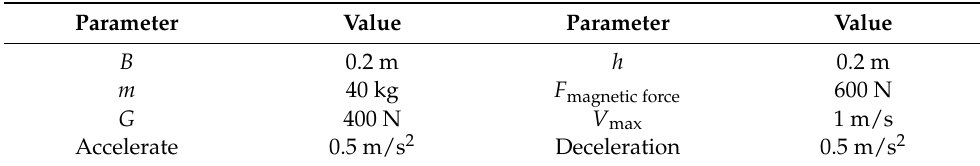
Table 2. Simulation